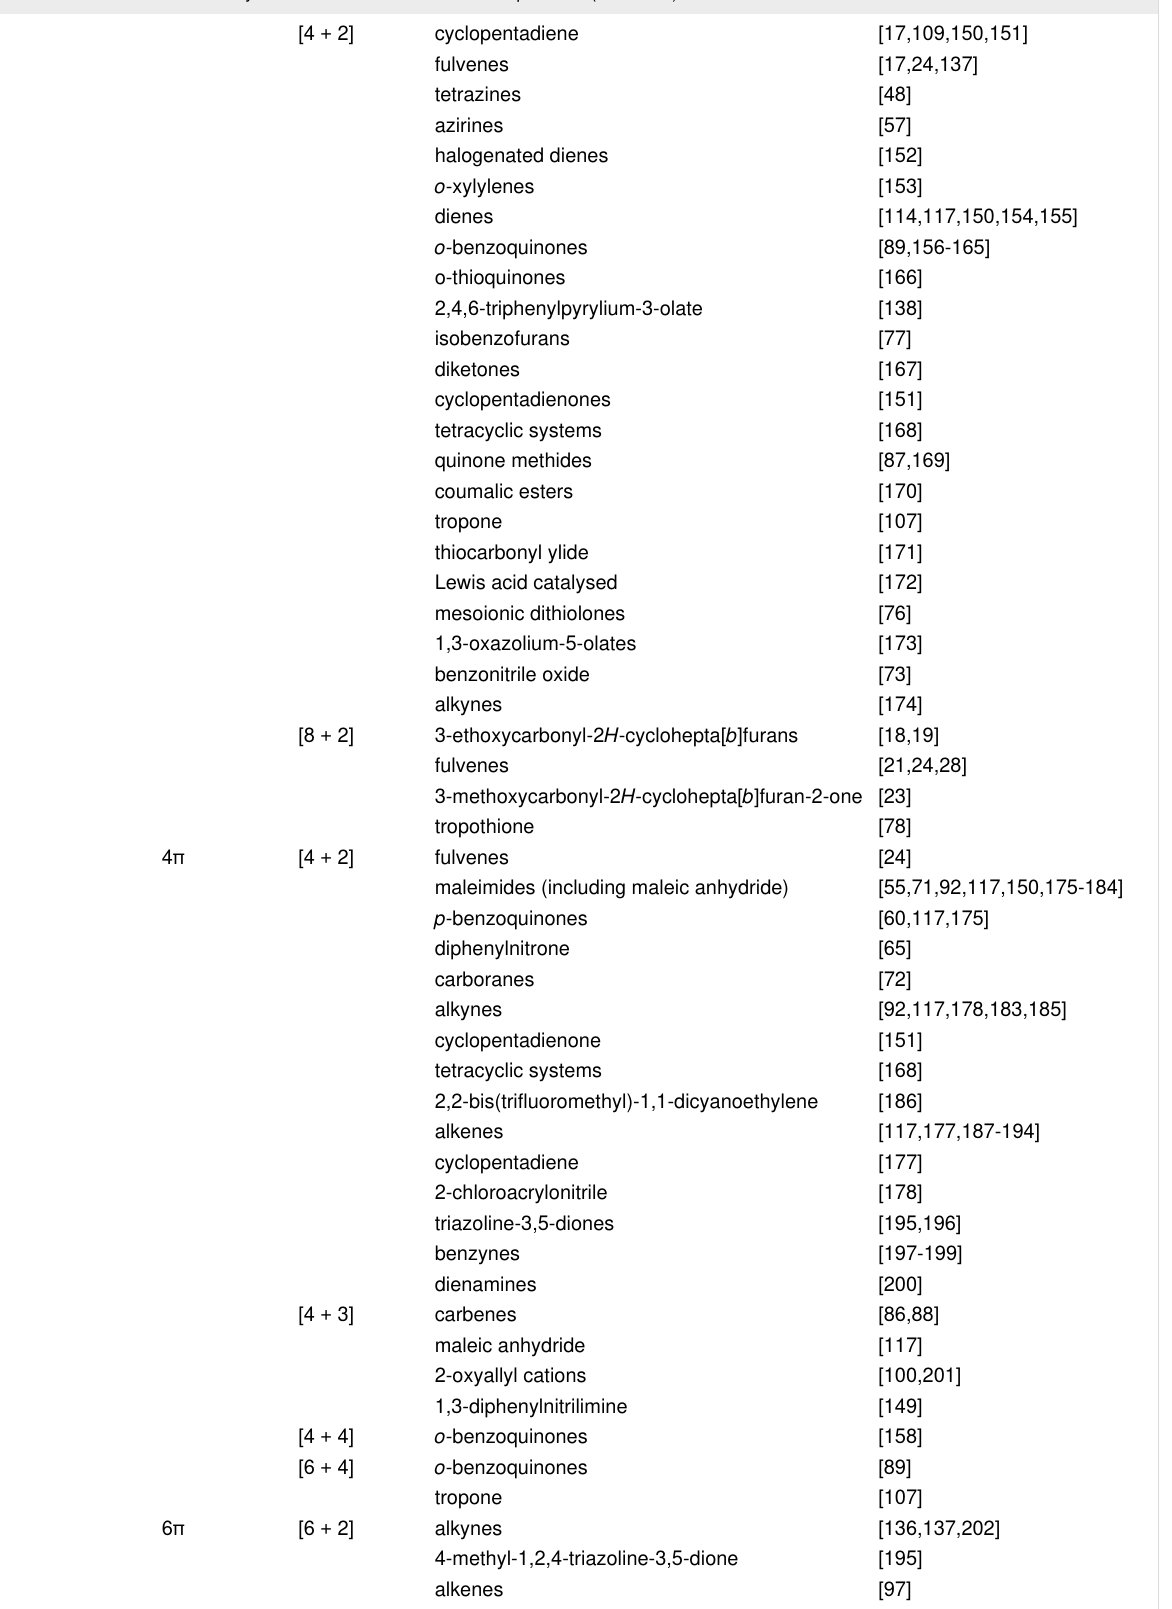
Table 2: Fulvene intermolecular cycloadditions with various reactant partners.